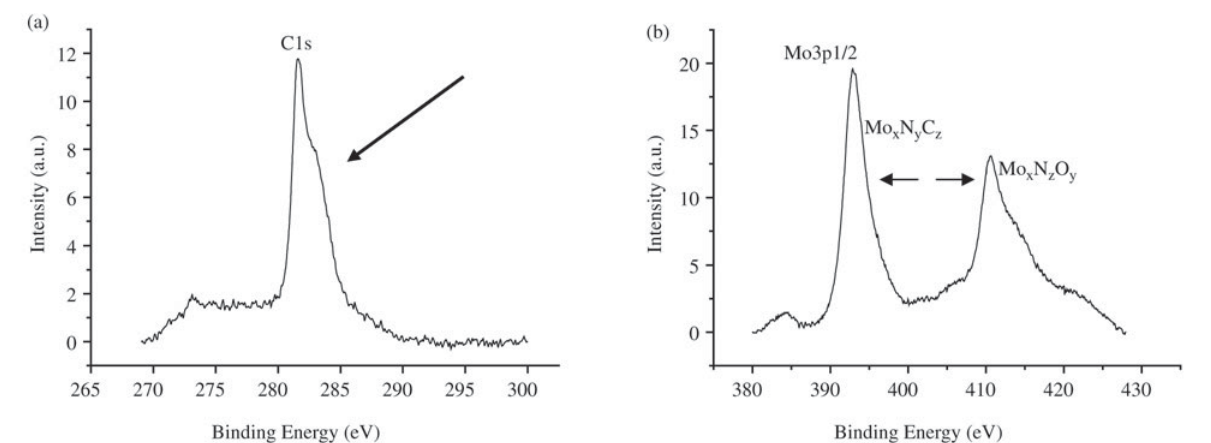
Figure 4. XPS analysis characterization for nitrated molybdenum after 10 min diamond growth: a) shifted and asymmetric binding energy peak for the carbon; b) shifted and asymmetric binding energy peaks for molybdenum